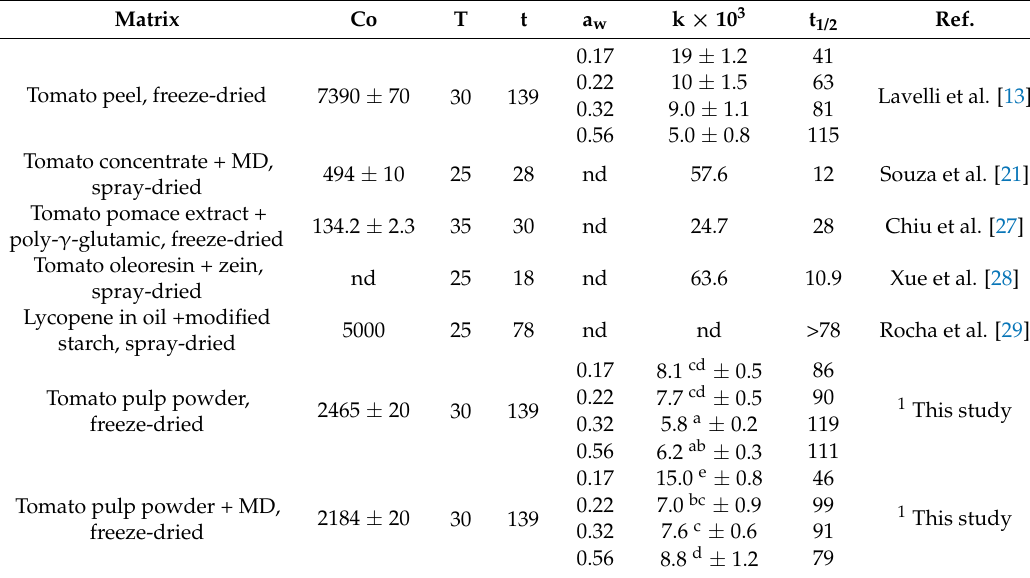
Table 2. Initial concentration (mg/kg dry weight), storage temperature (°C), time (d), a w , first-order rate constant (d − 1 ) and half-life (d) of lycopene in various matrices.